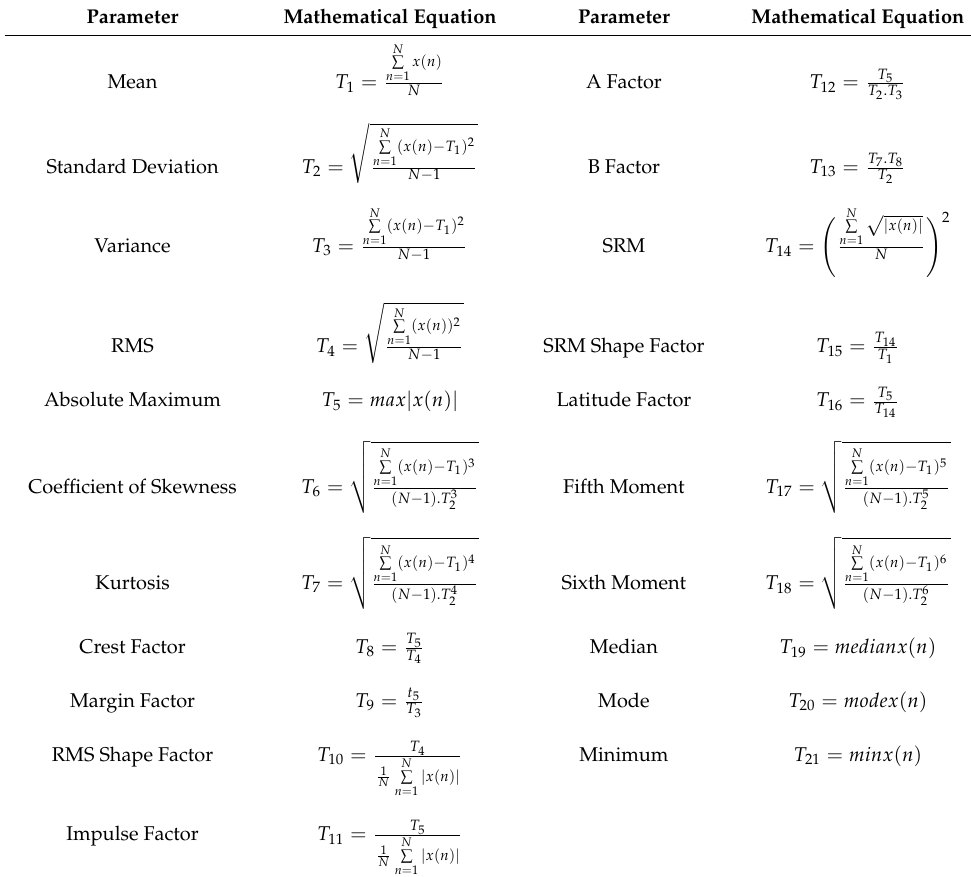
Table 3. Mathematical equations for time-domain-based statistical